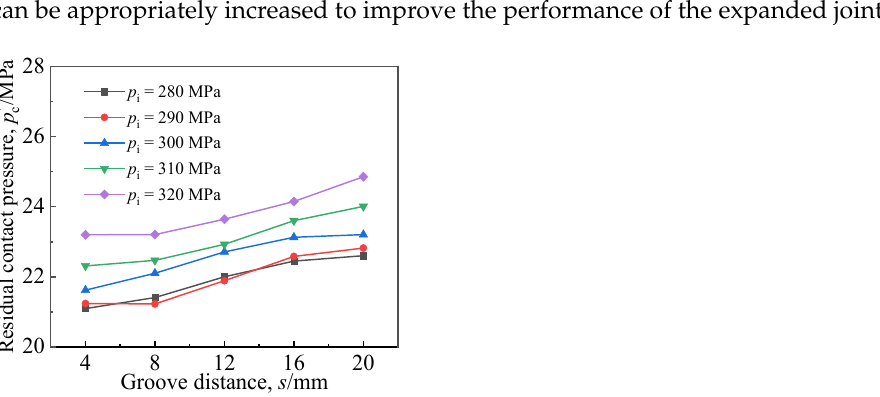
Figure 16. Effects of groove width on pullout force.